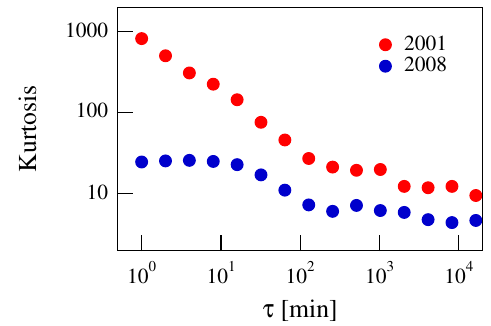
where ¯ x n ( t ) is the average on a moving time window of length n , for different values of the time window in the interval [ n,N max ] , and in calculating the scaling exponent of the σ DMA ( n ) , which is 220 expected to scale as σ DMA ( n ) ∼ n H .